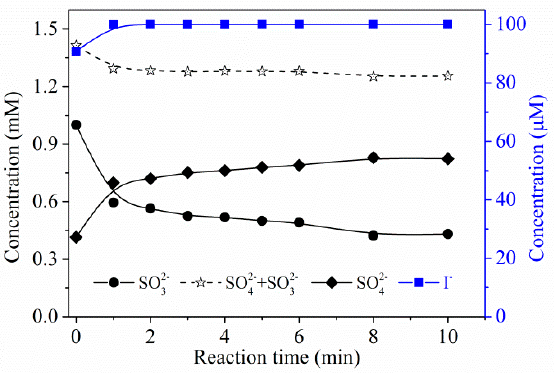
Figure 5. Mass balance of sulfur and iodine during degradation of BrO − using UV/sulfite/ I (cid:2879) process. Conditions: [BrO − ] 0 = 10 µ M, [I − ] 0 = 100 µ M, [sulfite] 0 = 1.0 mM, [DO] 0 = 7.0 mg · L − 1 , pH = 9.2, 20 ± 1 ◦ C.